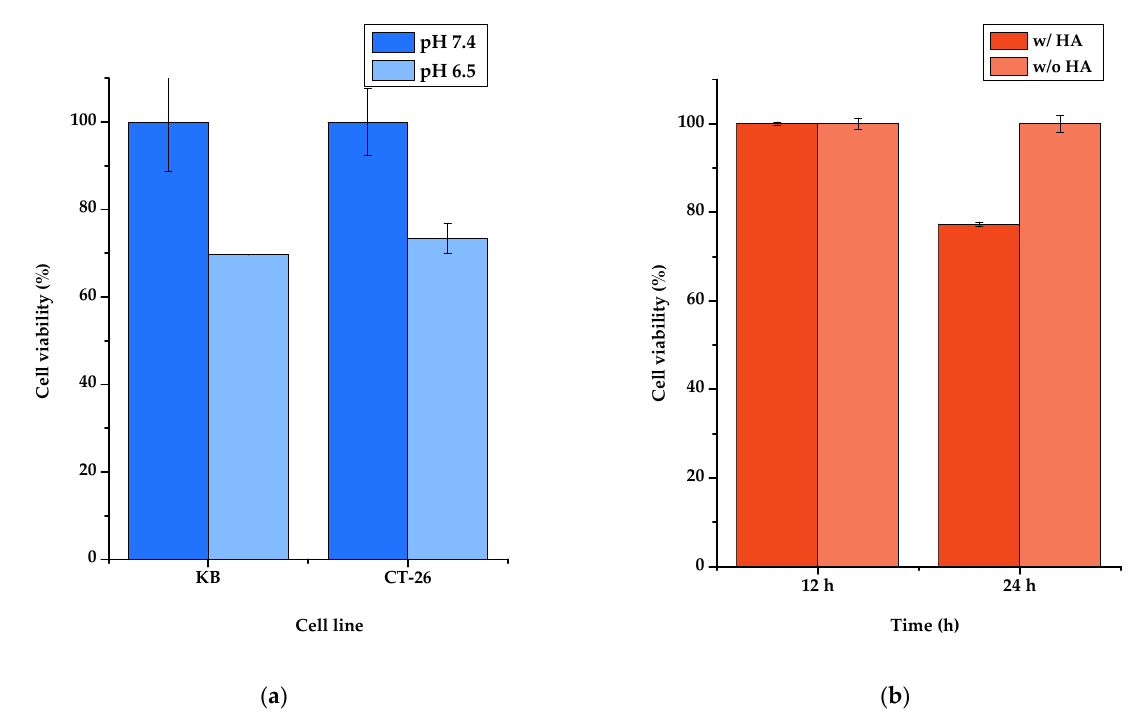
Figure 8. ( a ) Cytotoxicity study using Fe 3 O 4 @CeO 2 (100 µ g/mL) conducted on KB and CT-26 for 12 h; ( b ) cytotoxicity study using Fe 3 O 4 @CeO 2 (100 µ g/mL) without HA and Fe 3 O 4 @CeO 2 -APTES-HA (100 µ g/mL) with HA coating conducted on MDA-MB-231 for 12 and 24